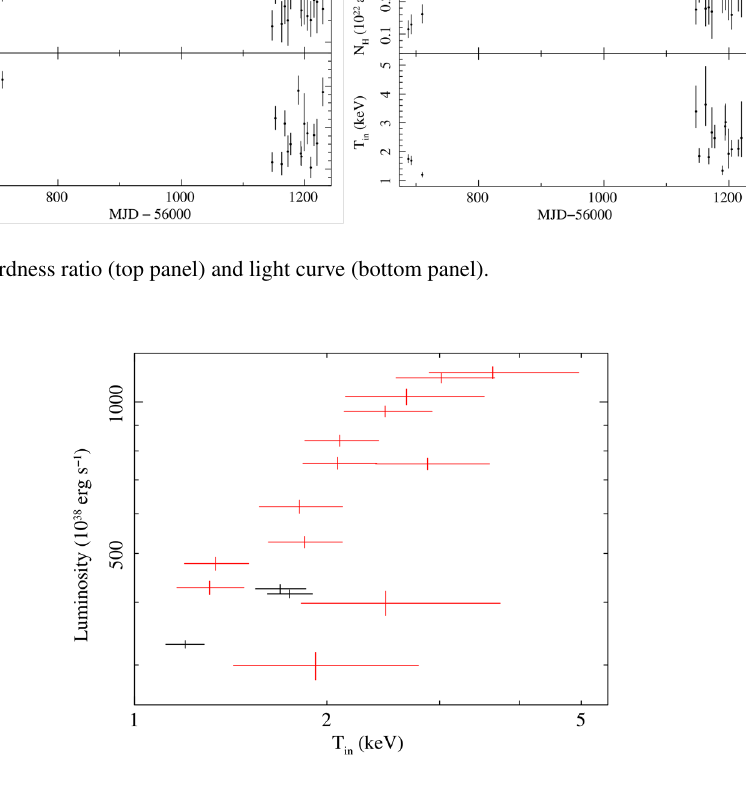
Figure 4. Temperature-luminosity plot, black for 2014 data and red for 2015